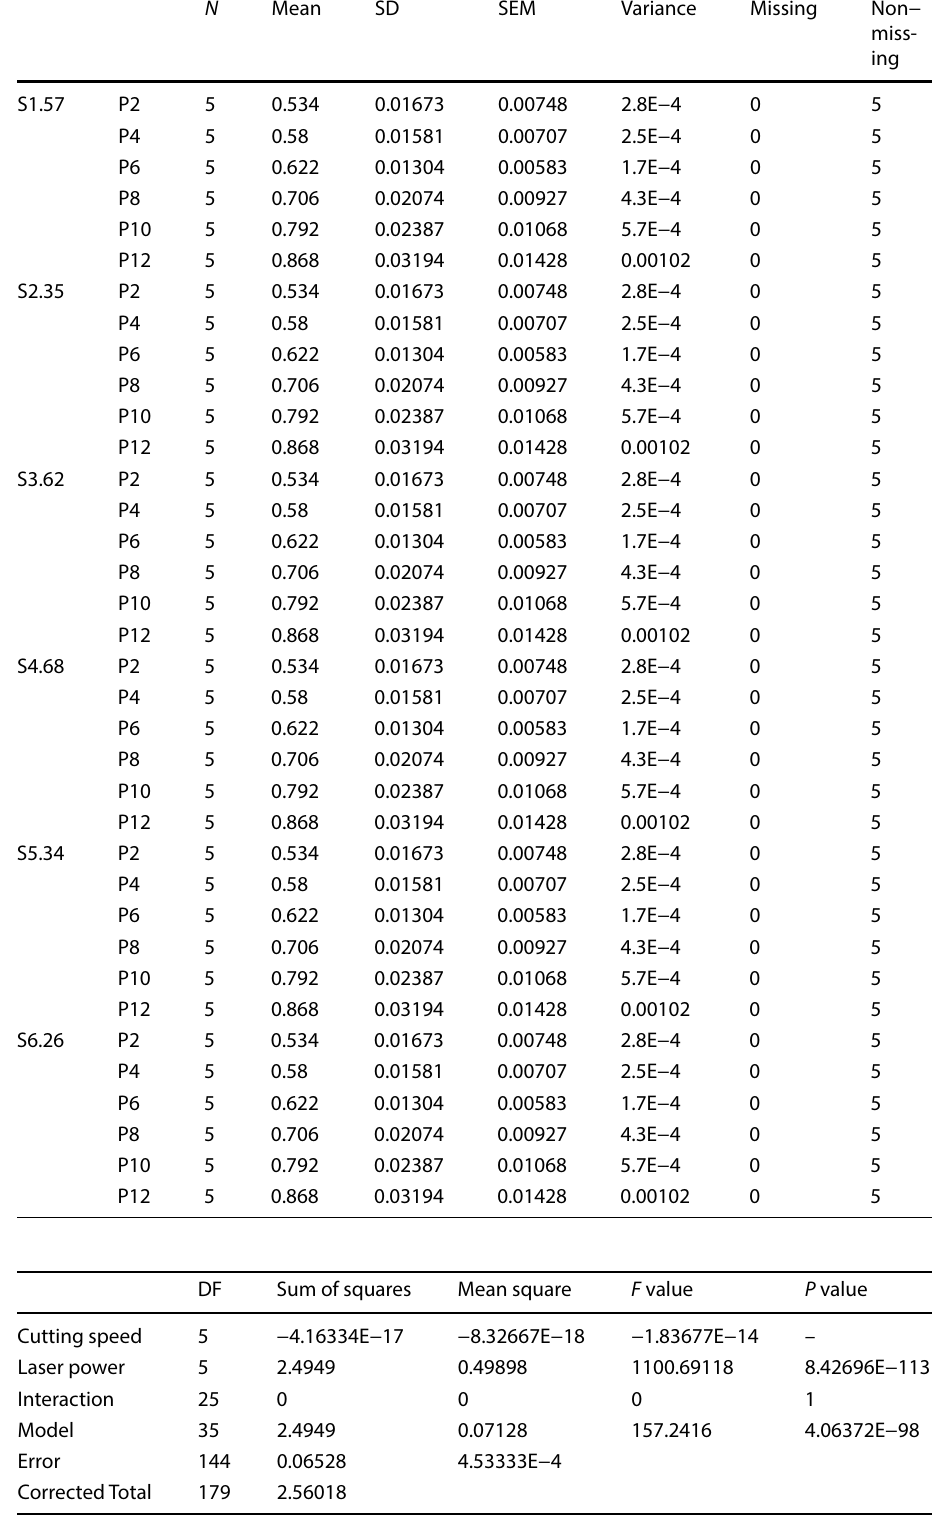
Table 30 Cutting speed & laser power